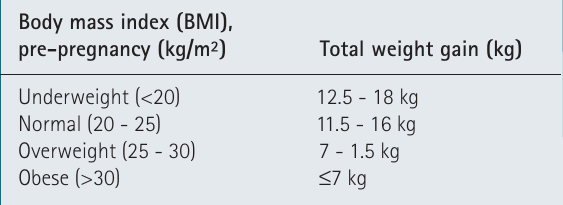
TABle 4.I. GeNeRAllY ACCePTABle INCReMeNTs OF WeIGHT DURING PReGNANCY